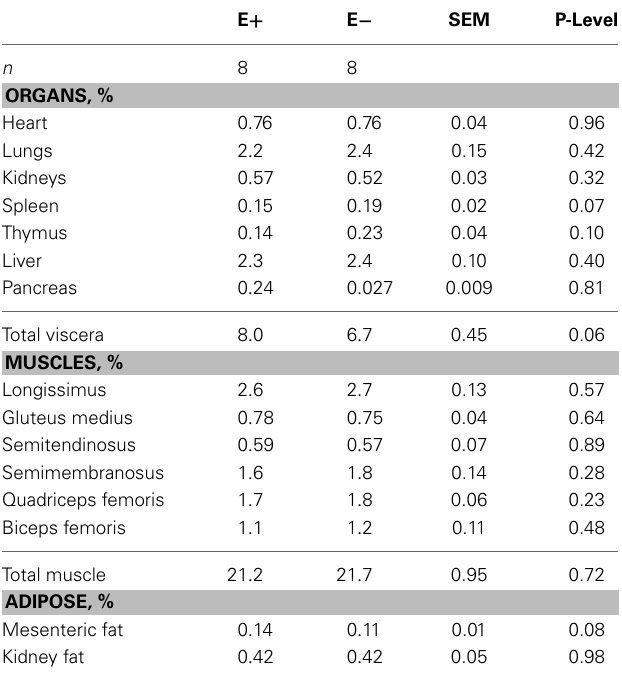
Table 3 | Effect of feeding tall fescue seed with endophyte (E + ) vs. endophyte-free (E − ) to ewes during gestation (d 35 to parturition) on lamb organ, muscle and adipose tissue weights as a percentage of body weight.